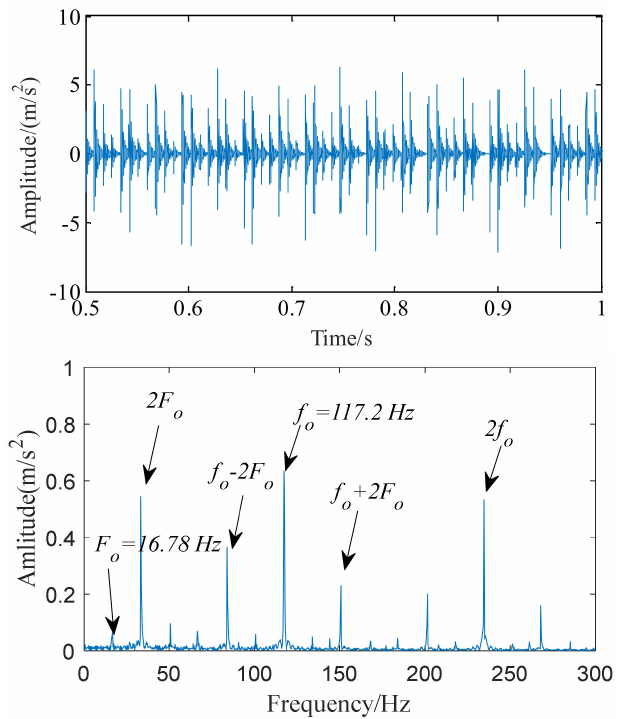
Figure 20. Time–domain waveform and spectrum of the OR fault signal (0.2 mm